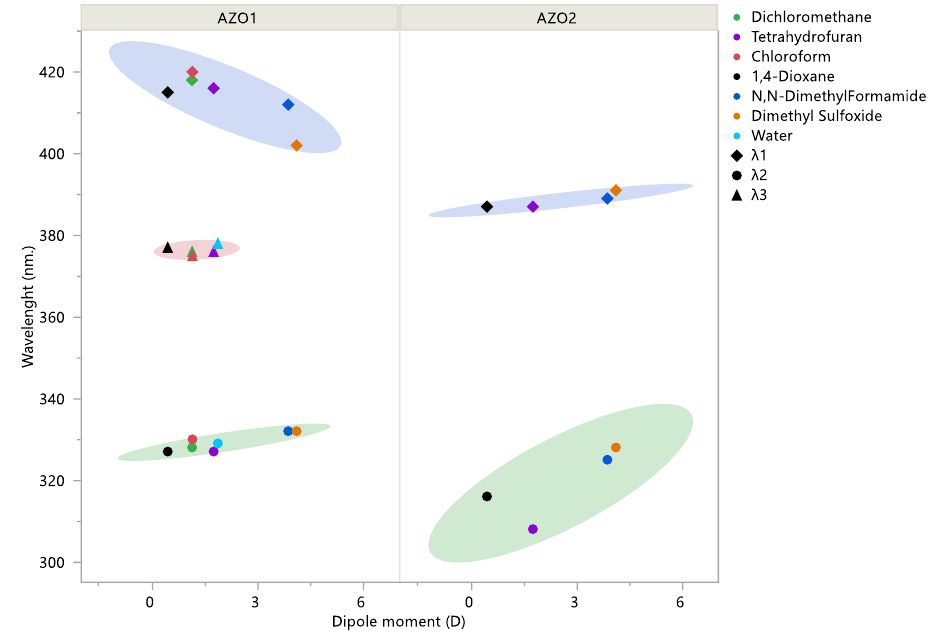
/ AZO2 correlated with solvent dipole moment Figure 5. Band absorption maxima of AZO1/AZO2 correlated with solvent dipole moment (Debye). Figure 5. Band absorption maxima of AZO1